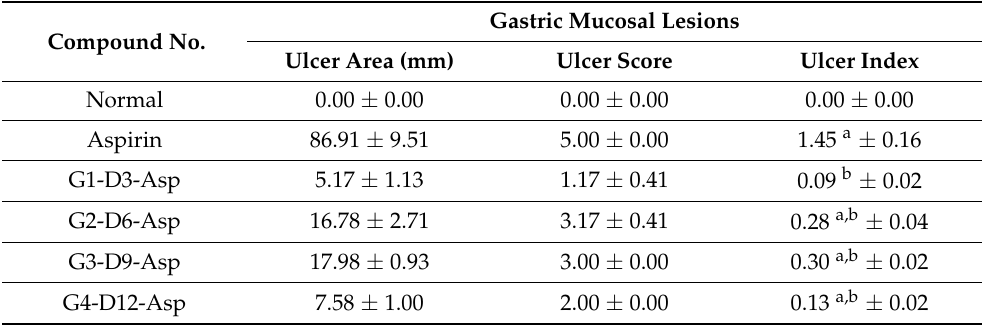
Table 6. Evaluation of the gastric mucosal lesions of the tested Aspirin-based dendrimers. Compound No.